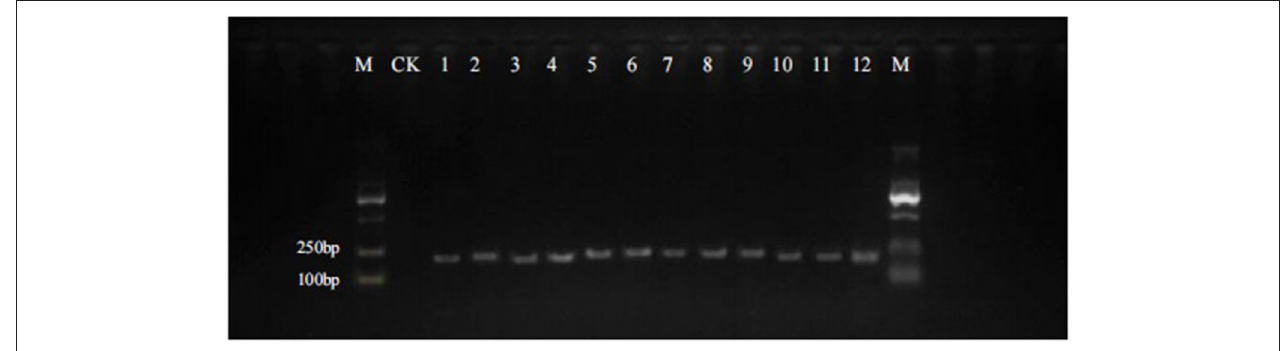
FIGURE 1 | PCR amplification of 12 batches of Qipi pill with the primer pair 4F/4R. M, DNA marker; CK, negative control; 1–12, samples of QPW1–QPW12.